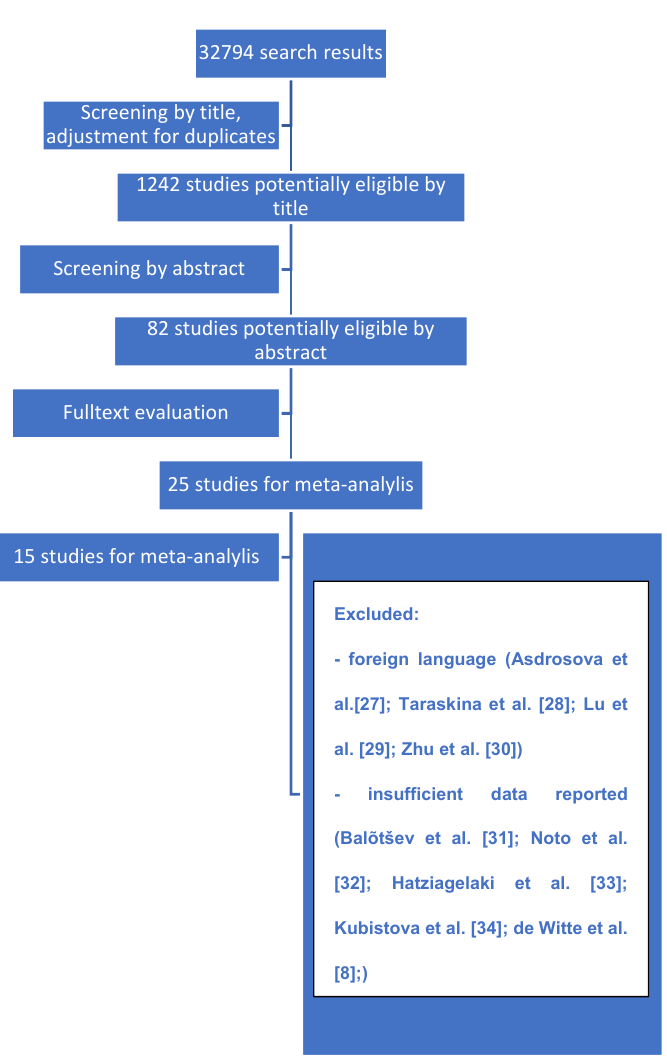
Figure 1. Study selection – flow diagram.